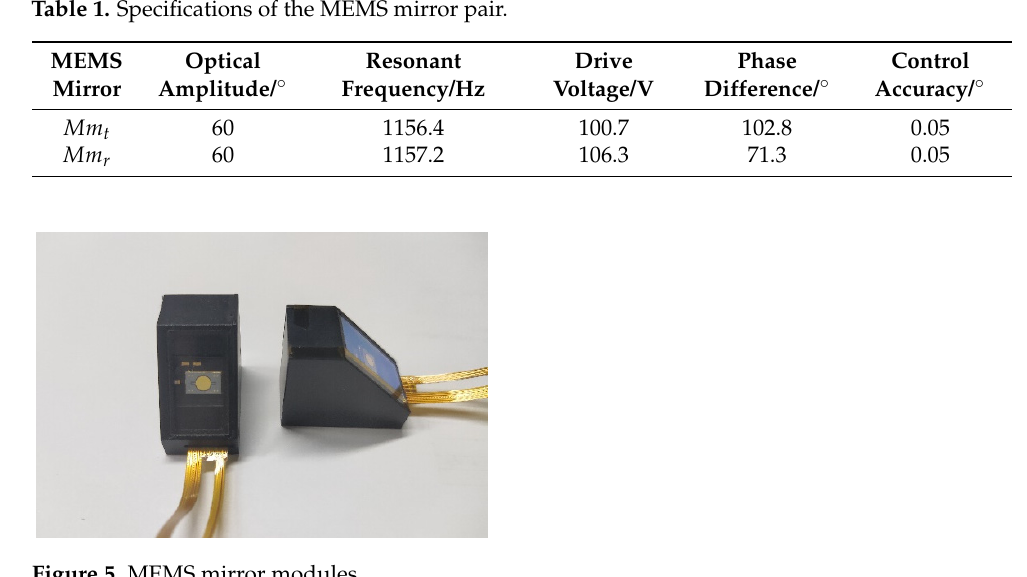
( c ) Figure 6. ( a ) The amplitude-frequency characteristic; ( b ) the phase-frequency characteristic; ( c ) the relationship between the scan amplitude and drive voltage. In this system, the MEMS mirror modules are connected to the main control board, which provides the power and drive signal of the MEMS mirrors. After power on, the